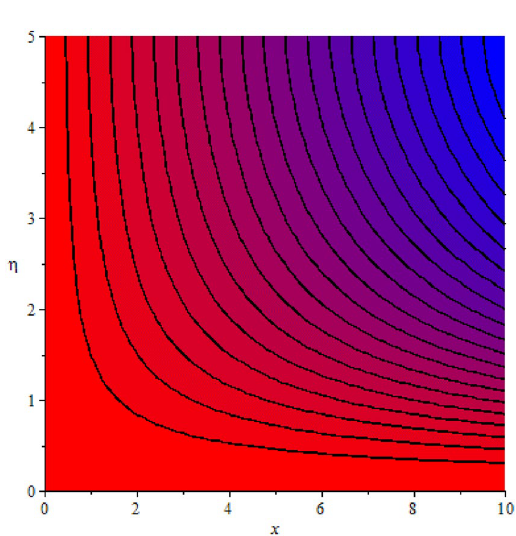
Figure 5. Stream lines when γ = 0.0 and K = 0.7.